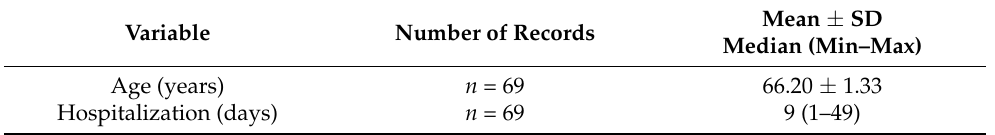
Table 1. Quantitative variables from patient records.